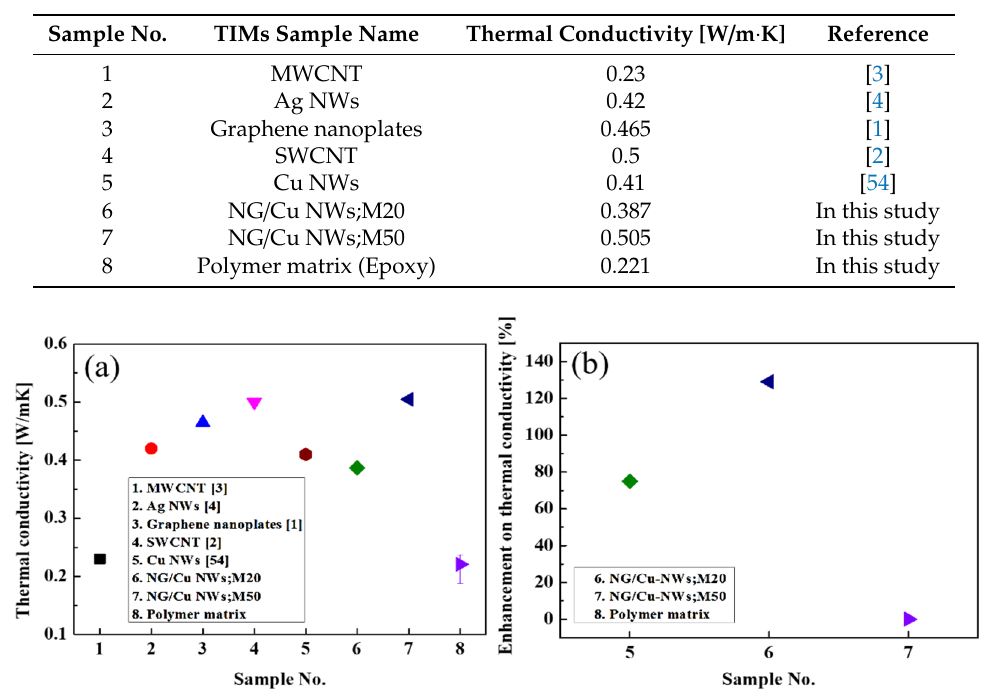
Table 1. The thermal conductivity and the TIMs.